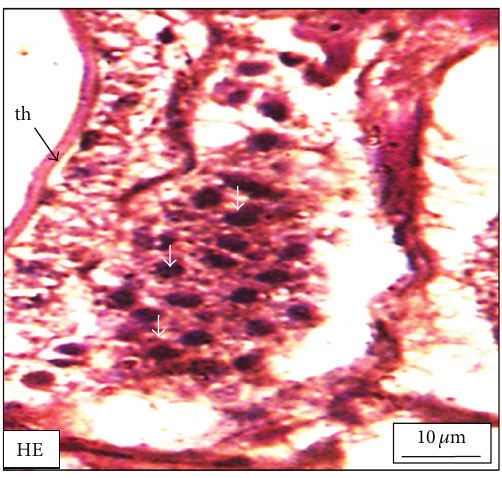
Figure 10: The histological section of the ovary of a M. tengara during the late spawning phase (August) displaying the yolk vesicle (yv) stages of oocyte without any trace of yolk deposition when the tissues are treated with ZnS nanoparticles at the concentration of 500 𝜇 g/L [IA: Iron-Alum Haematoxylin].